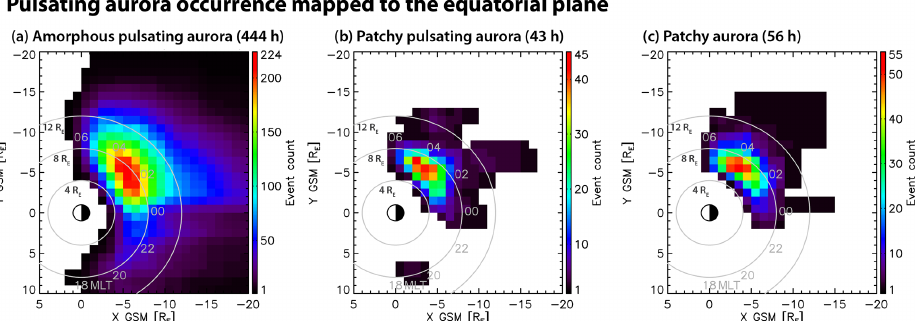
Figure 6. Pulsating aurora occurrence mapped to the equatorial plane. Pulsating aurora time and latitude boundaries were mapped using the T89 model (Tsyganenko, 1989) given Kp and the solar wind velocity GSE X component. This figure is based on the same set of events as shown in Fig. 4, excluding those with poor solar wind